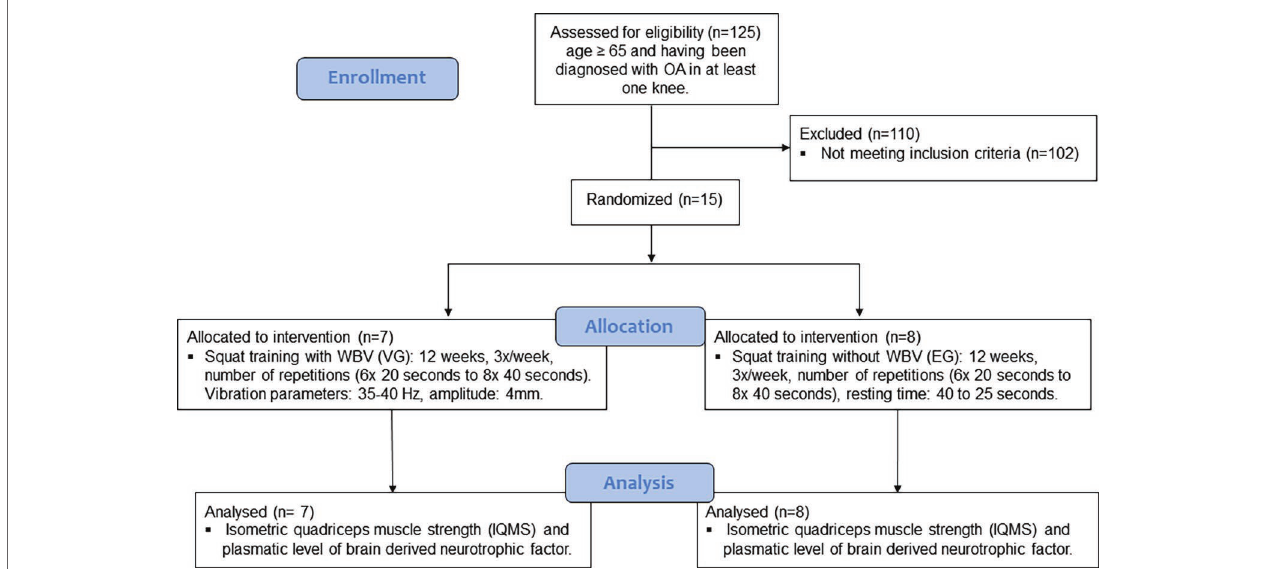
FIGURE 1 | The study flow chart. OA, osteoarthritis; VG, vibration group; EG, exercise group; WBV, whole body